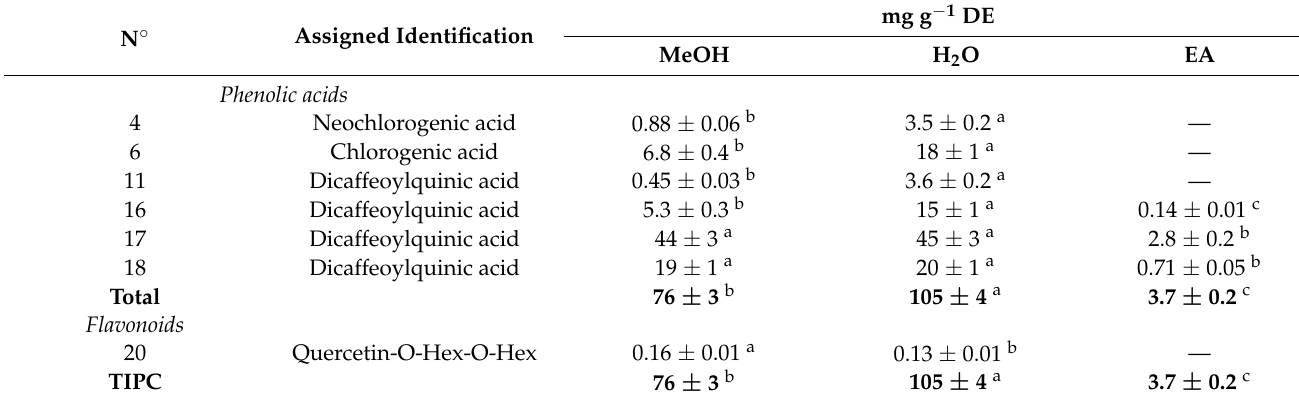
Table 3. Quantification of the main compounds detected in Artemisia verlotiorum .